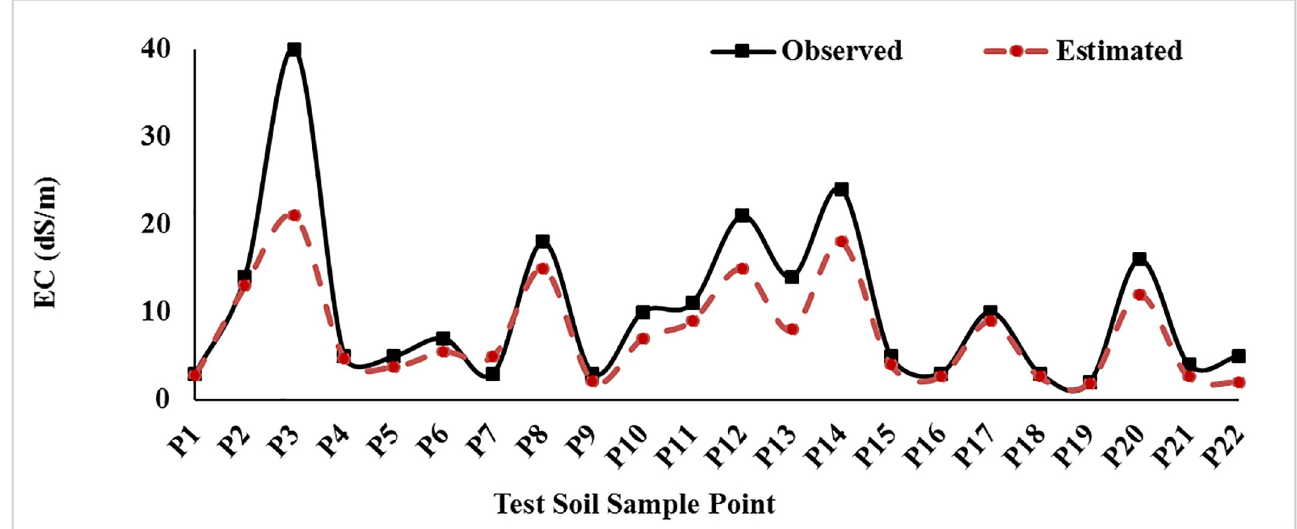
Fig 4. Comparison of estimated and observational EC in the selected data for testing the selected ANN model. In sample P3, the maximum difference of estimated EC and observed EC was found.